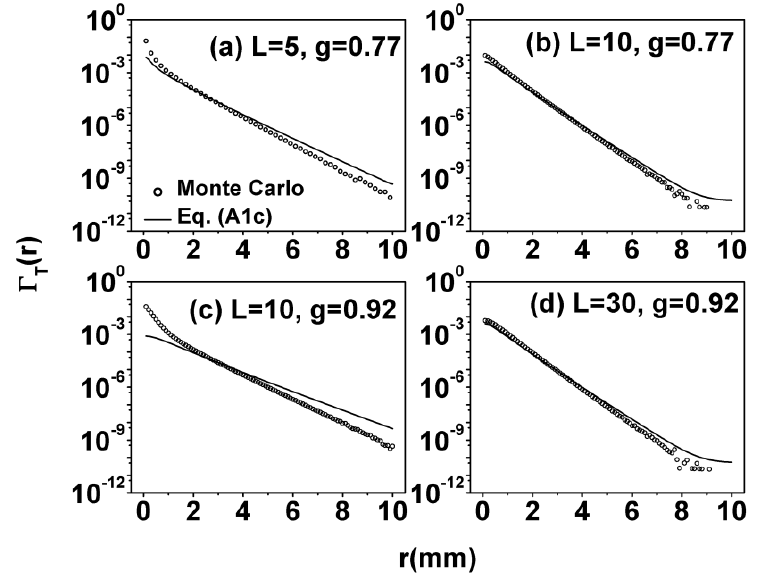
Figure 1. Comparison of the radial distribution of transmitted photons at large